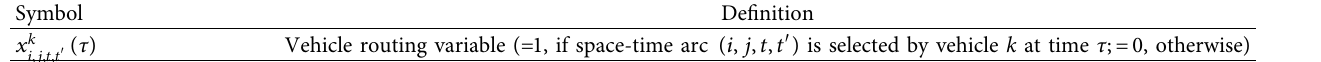
Table 5: Decision variable for model